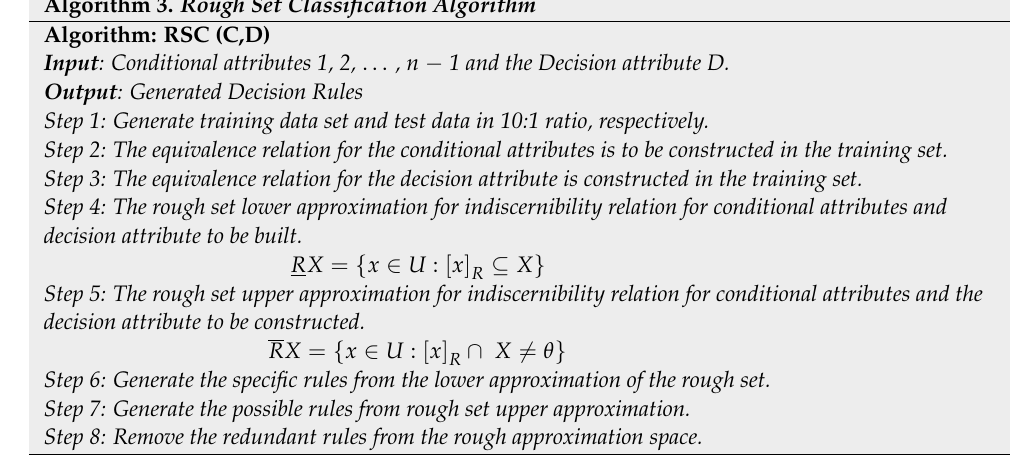
Algorithm 3. Rough Set Classification Algorithm Algorithm: RSC